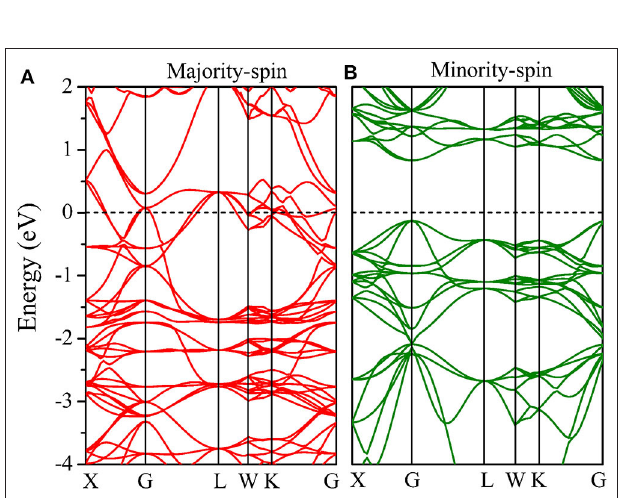
mechanical properties of CoCrScSn are stable in the range of 5.6–